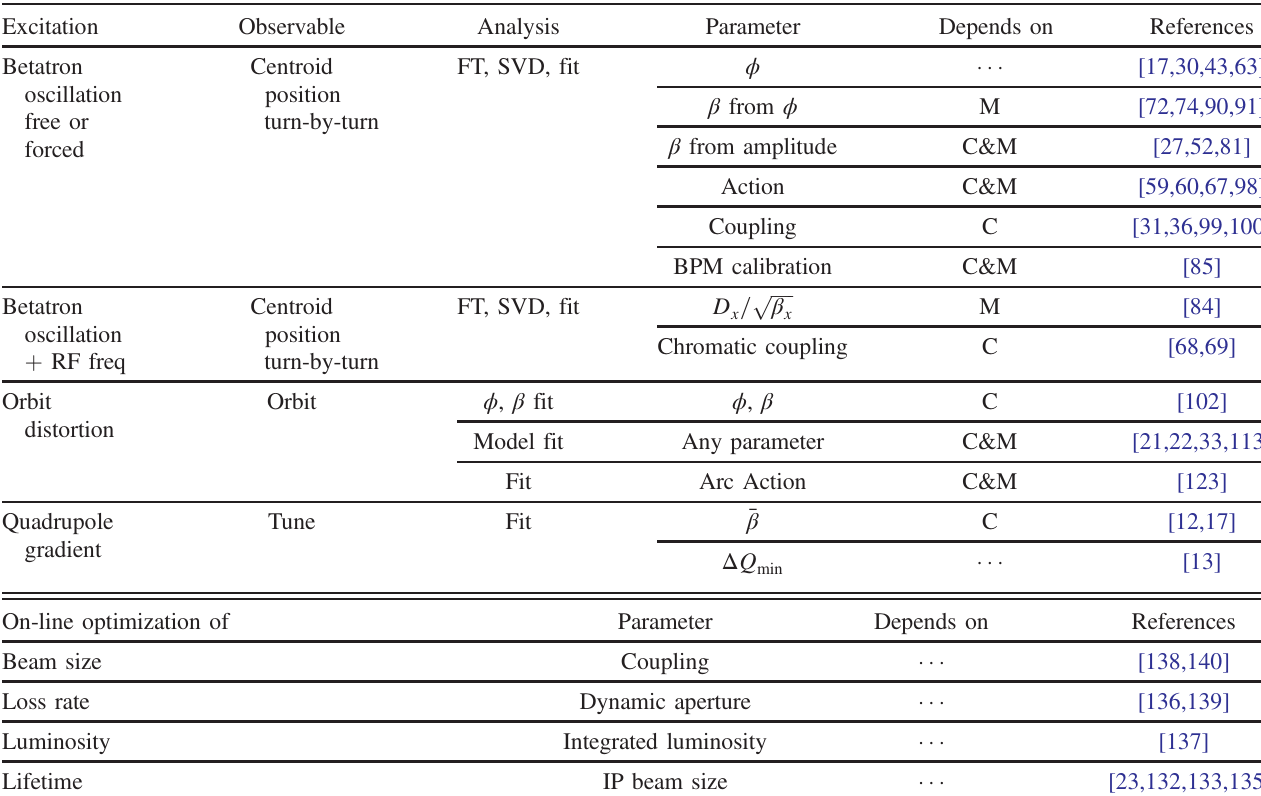
I. Overview of measurement techniques. The meaning of acronyms and symbols follows. C: Calibration or tilt; FT: Fourier transform; M: Model; SVD: Singular value decomposition; ϕ , β and D x : phase advance, beta function and dispersion; function over a quadrupole; Δ Q : closest tune min